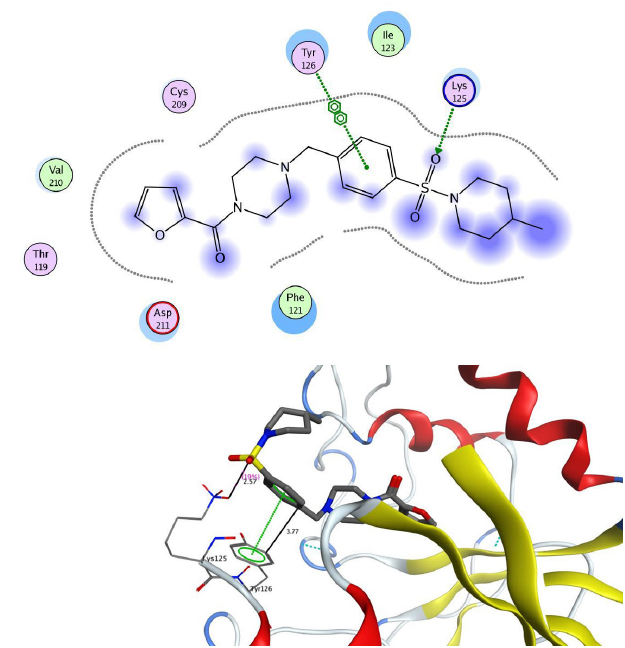
FIGURE 3 - The 2D and 3D interaction analysis of 2-furyl(4- {4-[(4-methyl-1-piperidinyl)sulfonyl]benzyl}-1-piperazinyl) methanone ( 5f ) with